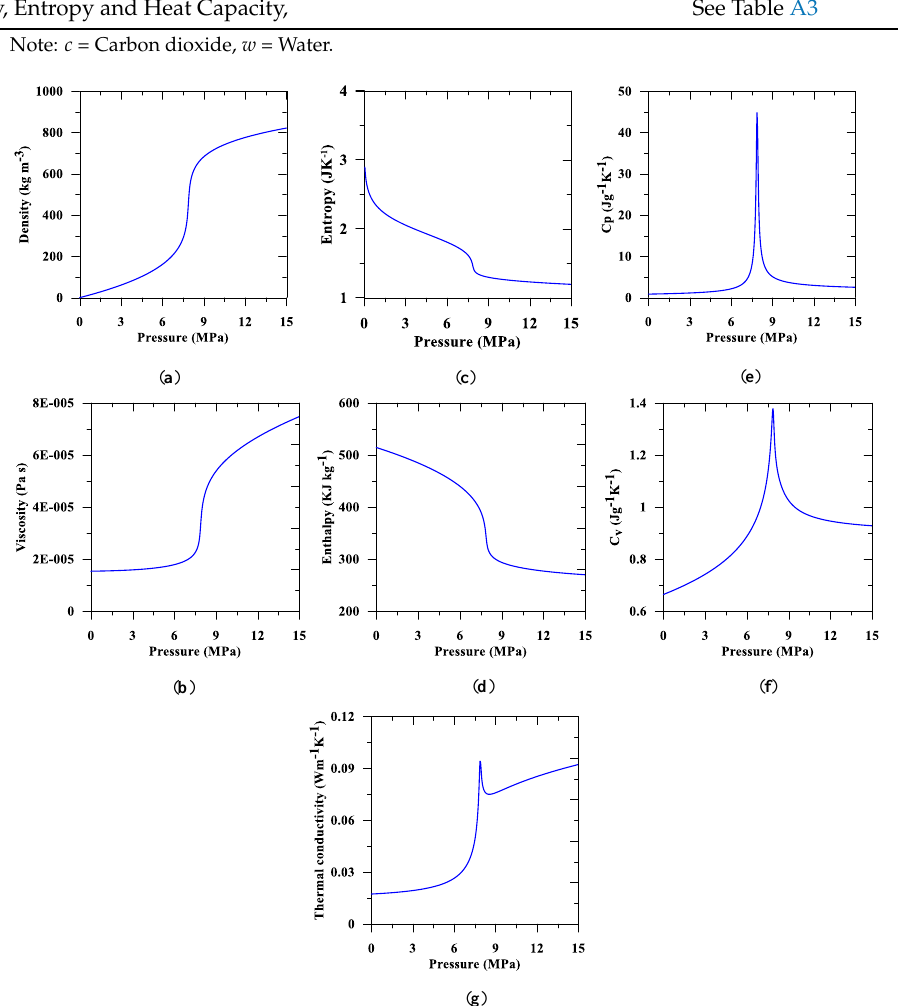
Figure A1. Properties of CO 2 at 307.15 K ( a – g ; see also CoolProp Package: Bell et al. [57] ) .